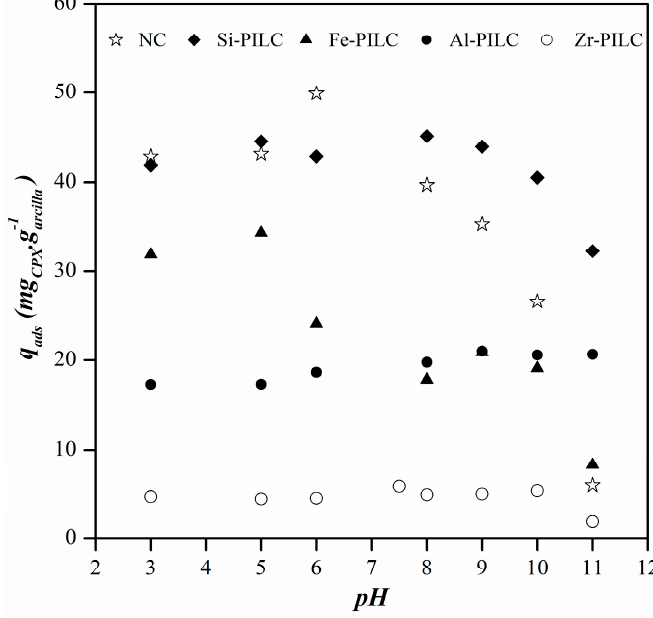
Figure 4. Effect of media pH on ciprofloxacin (CPX) adsorption.